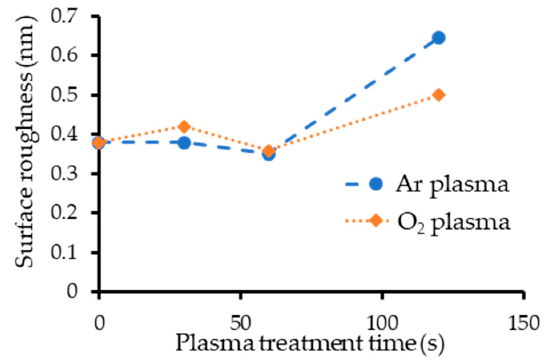
Figure 1 . Root mean square (RMS) surface roughness vs. plasma treatment